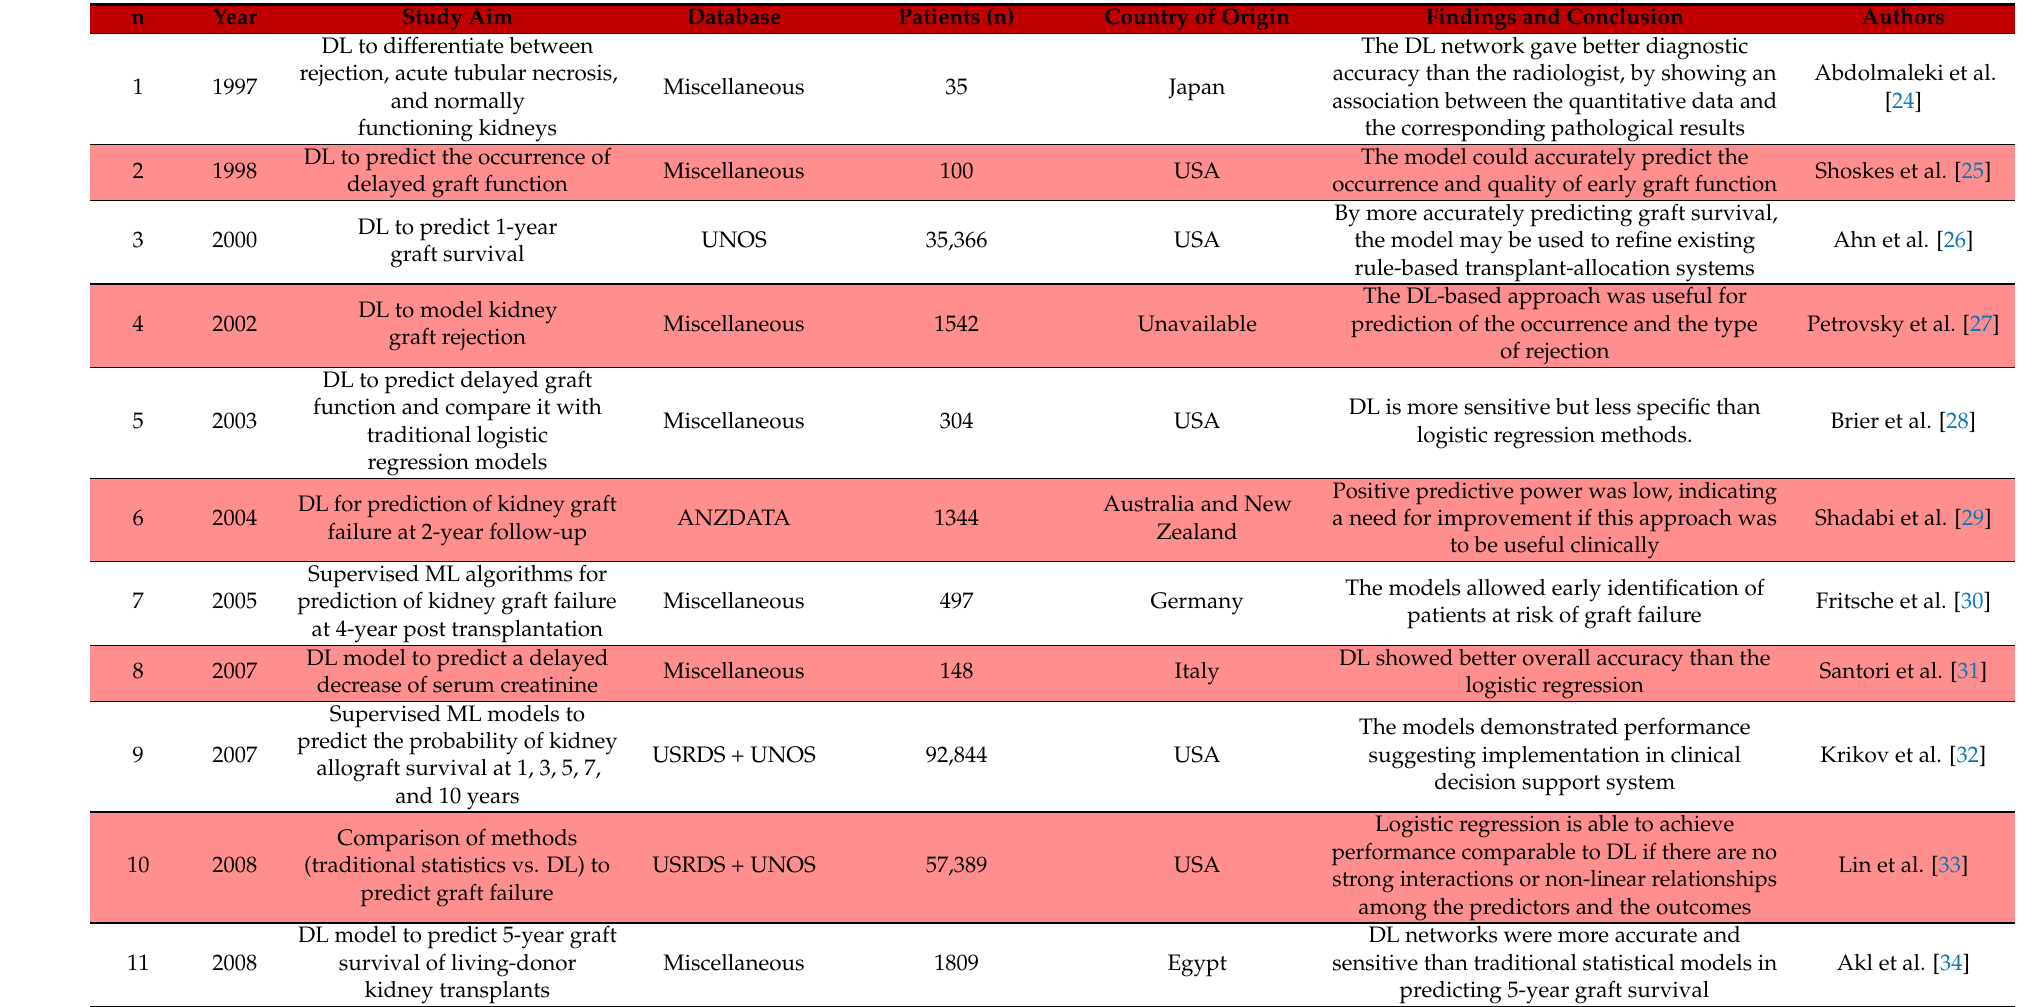
Table 1. Studies in the field of kidney transplantation that have used AI for data